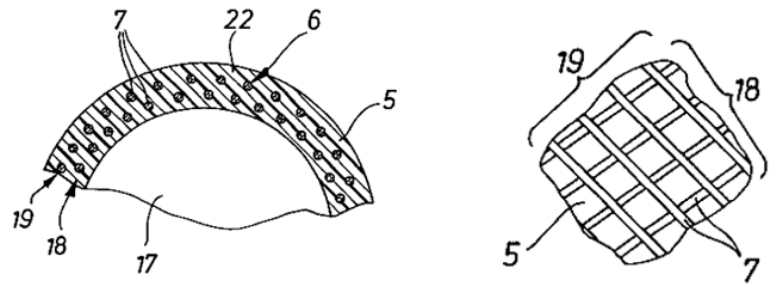
Figure 2. Layout of the aramid fibre mesh.